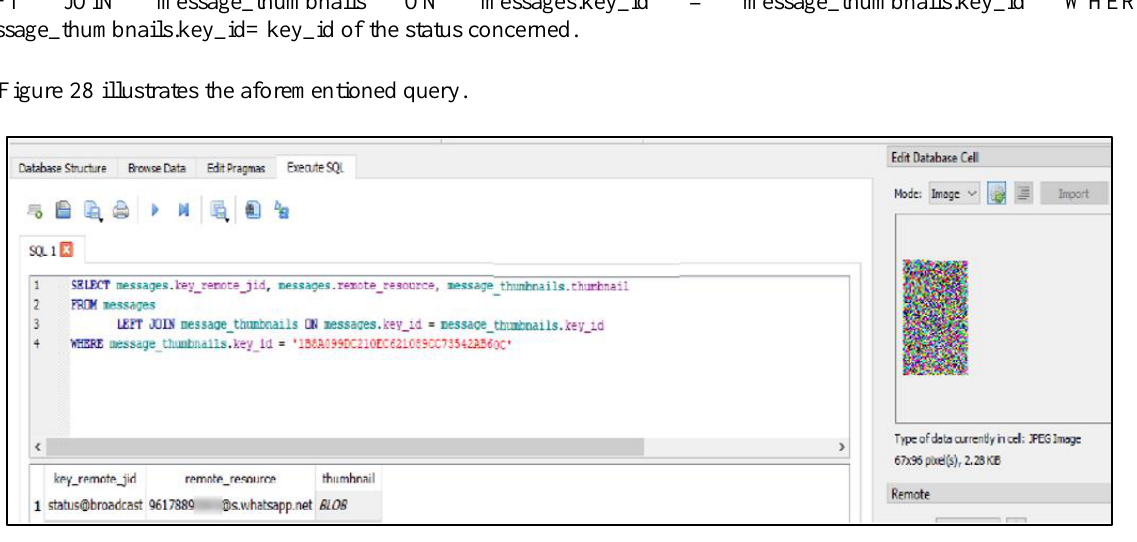
Figure 28. Identification of the status picture using SQL